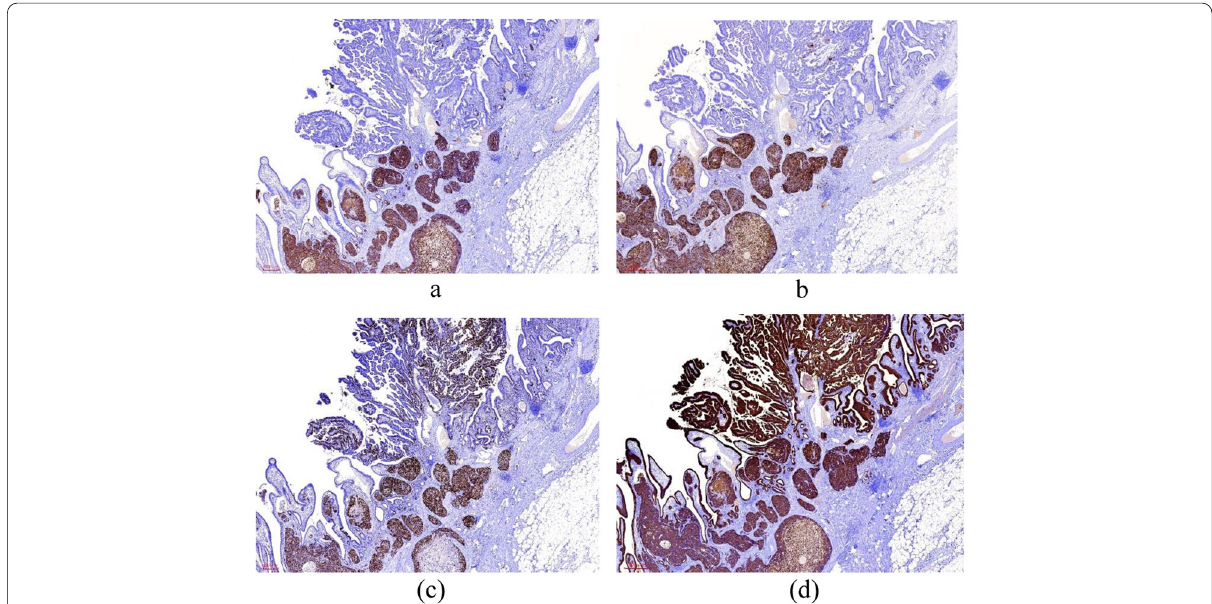
Fig. 6 Case 2: Immunohistochemical staining findings for LCNEC and adenocarcinoma. a Syn staining was diffuse and strongly positive in LCNEC, and negative in adenocarcinoma. Magnification, 20. b CgA staining was diffuse and strongly positive in LCNEC, and negative in adenocarcinoma. × Magnification, 20. c A high Ki67 proliferation index was identified in the LCNEC and the adenocarcinoma component. Magnification, × AE3 staining was strongly positive in both adenocarcinoma and the LCNEC component.